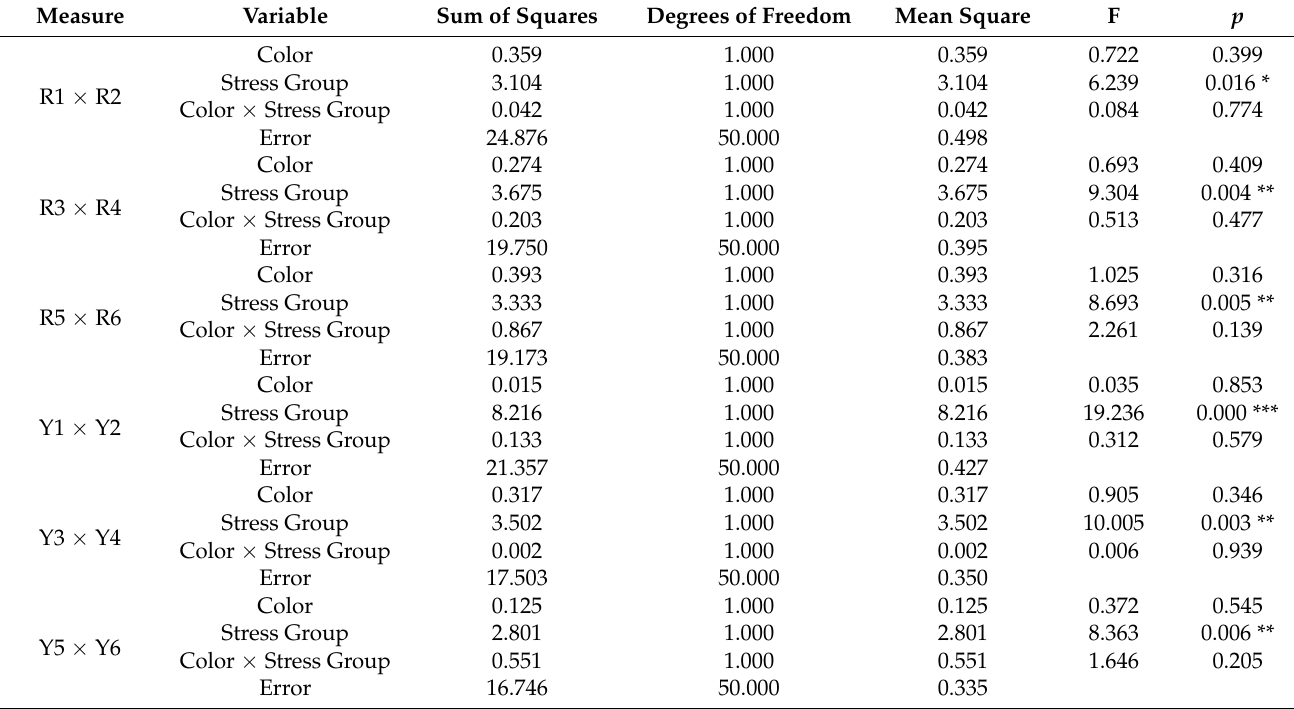
Table 12. The main effect and interaction by brightness changes and stress groups of